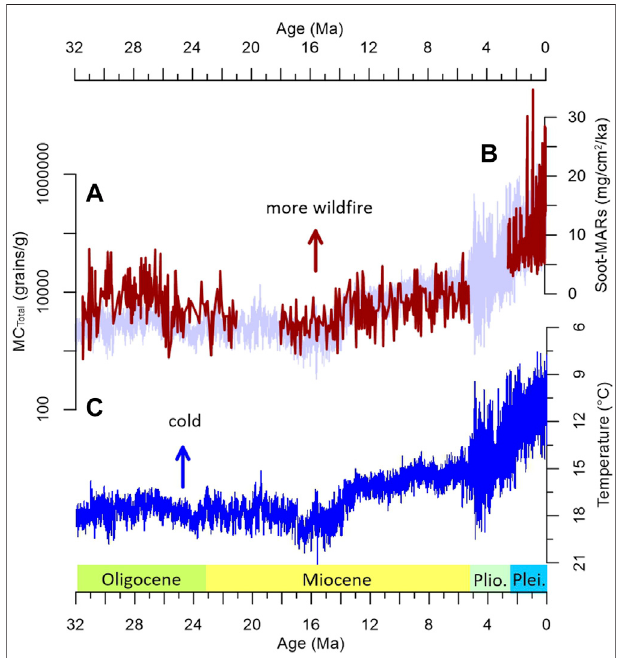
FIGURE 5 | Correlations between wild fi re in Inner Asia and global temperature. (A) . the MC records from the HTG section (this study) and KC-1 core (18 – 5 Ma) from the Qaidam Basin (Miao et al., 2019). (B) . Quaternary fi resindicatedbysoot-MARsreconstructedfromChineseLoessPlateau (Han et al., 2020). (C) . global temperature curve (Westerhold et al.,